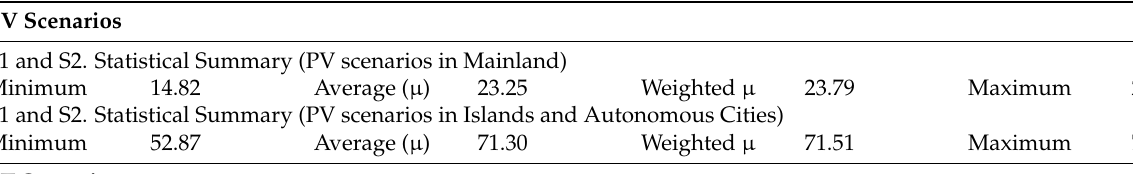
Table 19. PV and ST ERR according to location and scenario (in